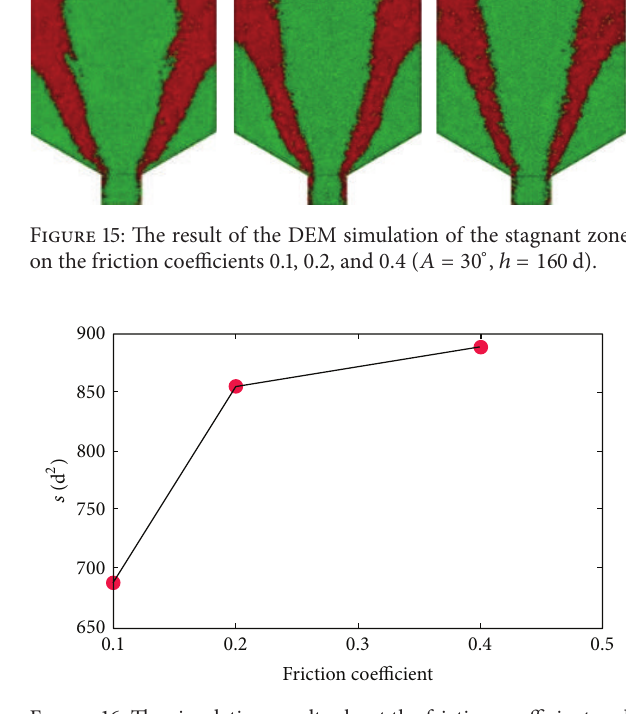
Figure 16: The simulation results about the friction coefficient and the stagnant zone size ( 𝑓 = 0.2 , ℎ = 160